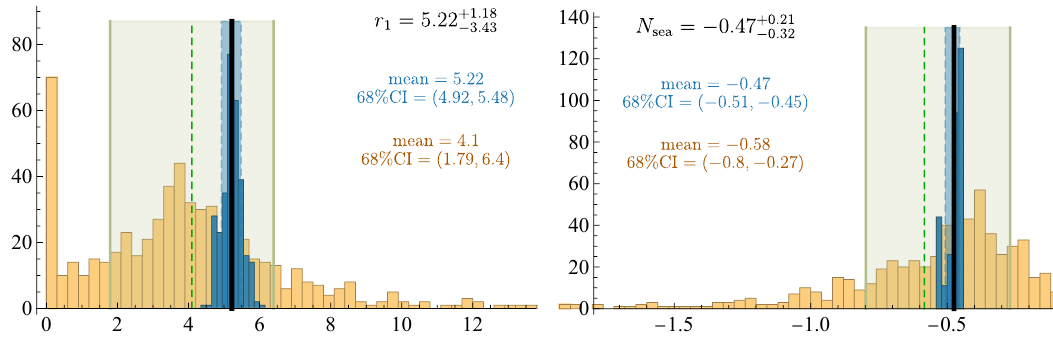
Figure 3. Examples of histograms of parameter distribution for r 1 and N sea obtained in the joined fit of SIDIS and DY data. The orange histogram is the distribution due to experimental uncertainties (500 replicas). The blue histogram is the distribution due to SV19 extraction (300 replicas). The green dashed line and green band (the black line and blue band) show positions of the mean value and 68%CI for distribution due to experimental uncertainties (due to SV19